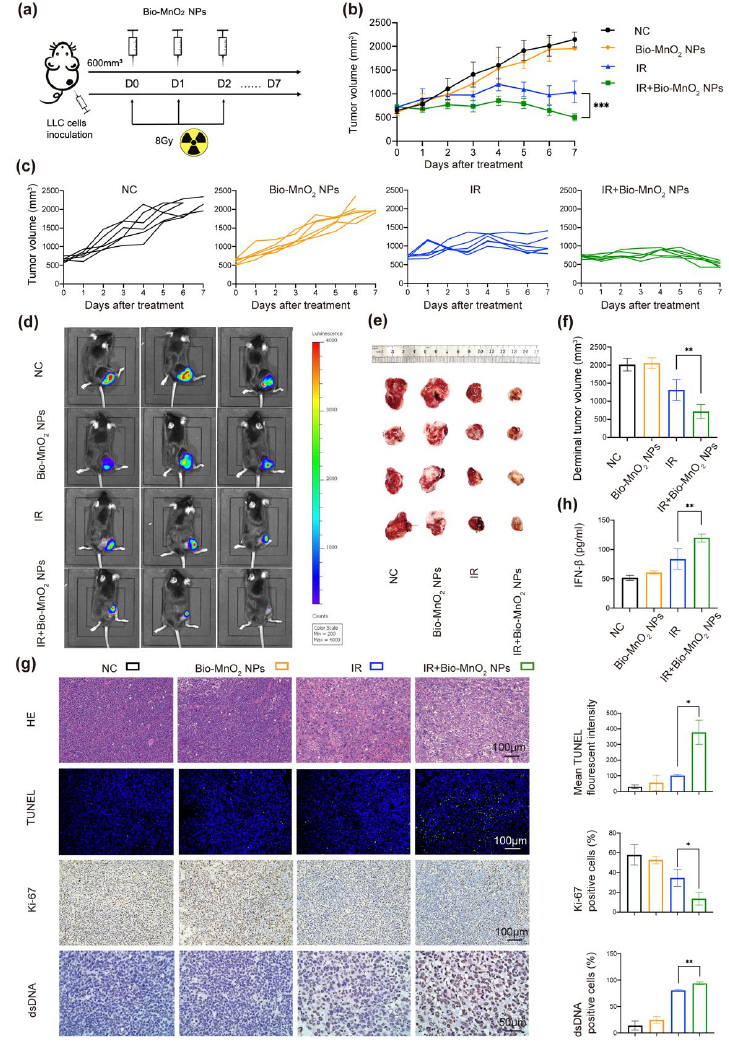
Figure 7. Bio-MnO 2 NPs enhanced RT in vivo. ( a ) Schematic illustration of the experiment in vivo. ( b ) Growth curve of tumor volume after different treatments: negative control (NC), Bio-MnO 2 NPs, IR and IR + Bio-MnO 2 NPs. ( c ) Tumor growth curve of each mouse. ( d ) Representative fluorescence of tumors. ( e ) Representative images of tumors. ( f ) Tumor volumes from each group when the mice reached the welfare end point. ( g ) Representative images and statistical graphs of H&E, Ki-67, TUNEL, dsDNA staining of tumors tissues. ( h ) Cytokine levels of IFN- β in sera after different treatments. *, p < 0.05; **, p < 0.01; ***, p < 0.001. In addition, we performed a series of experiments to estimate the biological compatibility of Bio-MnO 2 NPs in vivo. The alanine transaminase (ALT), aspartate aminotransferase (AST) and alkaline phosphatase (ALP) markers were normal, indicating